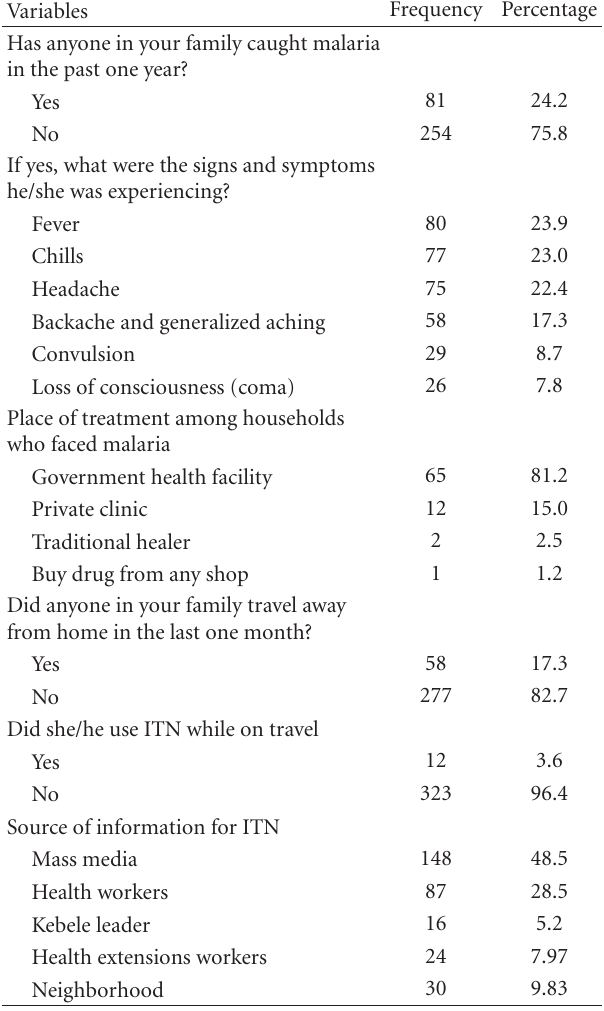
Table 3: Malaria knowledge and history in the past one year among respondents in Gursum district, Ethiopia,